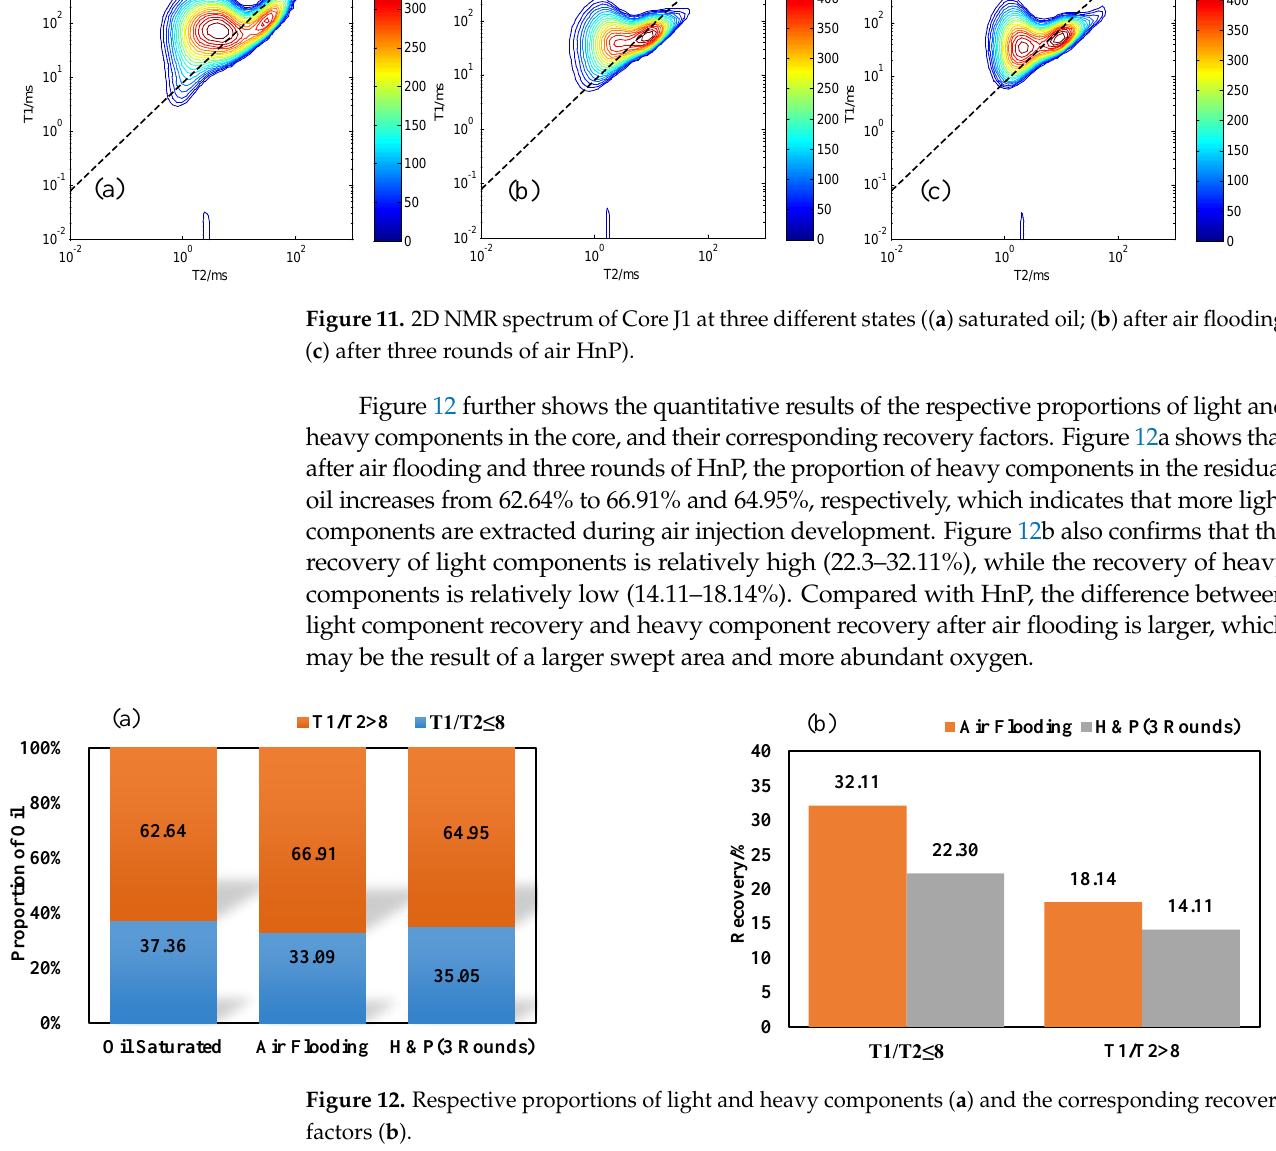
Figure 12. Respective proportions of light and heavy components ( a ) and the corresponding recov- ery factors ( b ).